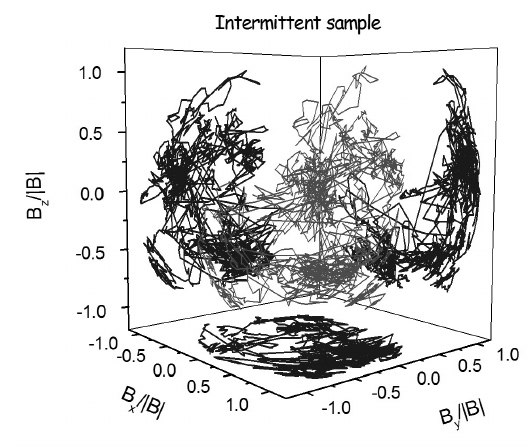
Figure 100: Still from a movie showing Trajectory followed by the tip of the magnetic field vector in the minimum variance reference system during a time interval characterized by intermittent events. The duration of the interval is 2000 (cid:214) 6 s but the magnetic field vector moves only for 100 (cid:214) 6 s in order to make a smaller file (movie kindly provided by A. Vecchio). (To watch the movie, please go to the online version of this review article at http://www.livingreviews.org/lrsp-2013-2